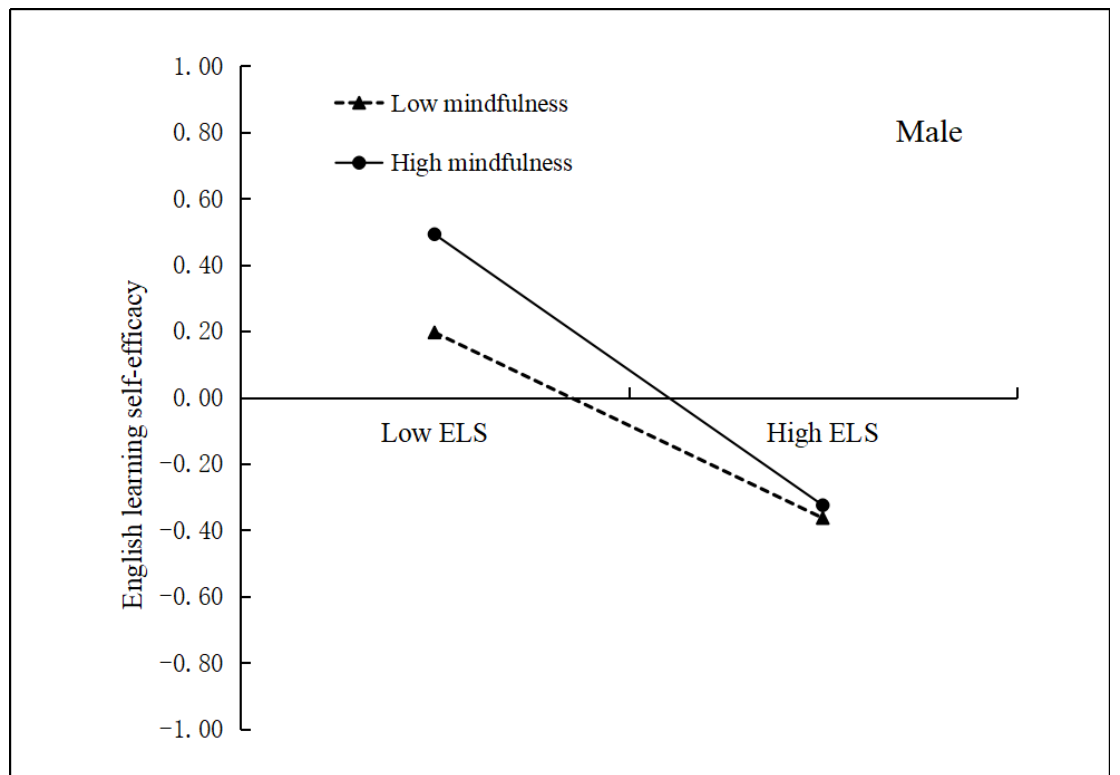
Figure 1. English learning self-efficacy as a function of English learning stress and mindfulness among male undergraduate students. ELS = English learning stress.